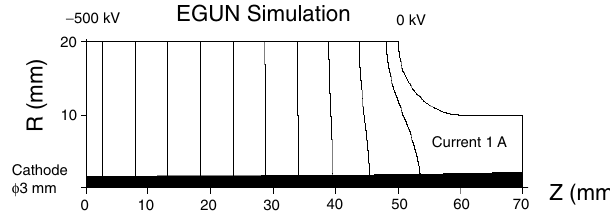
FIG. 3. Beam trajectory near the gun electrode.